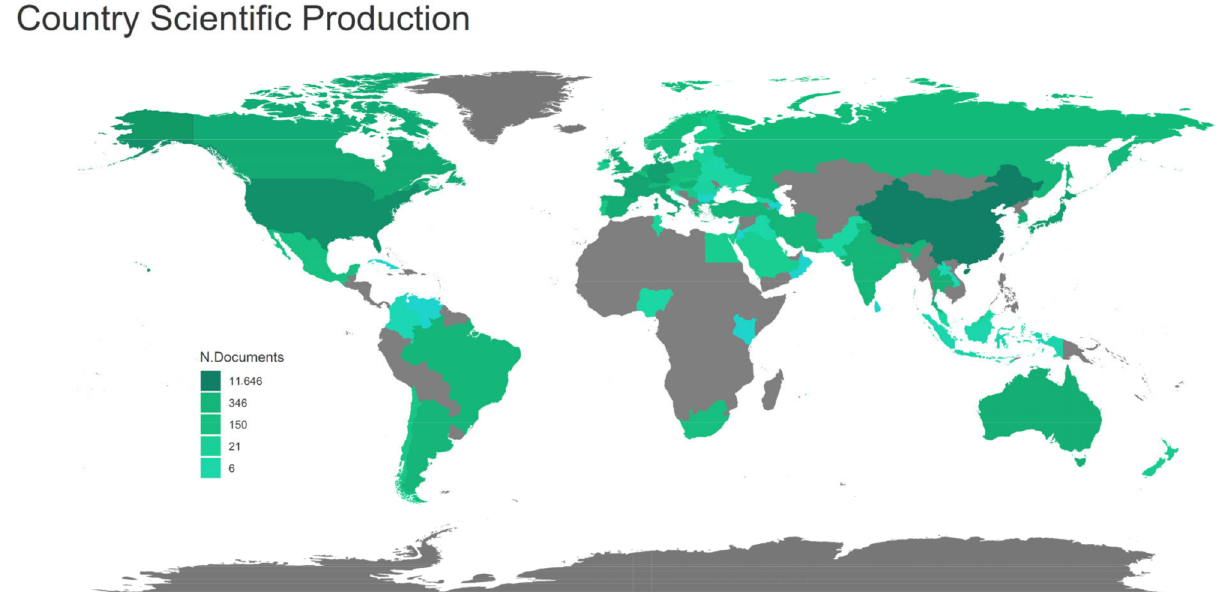
Figure 3. Articles published per